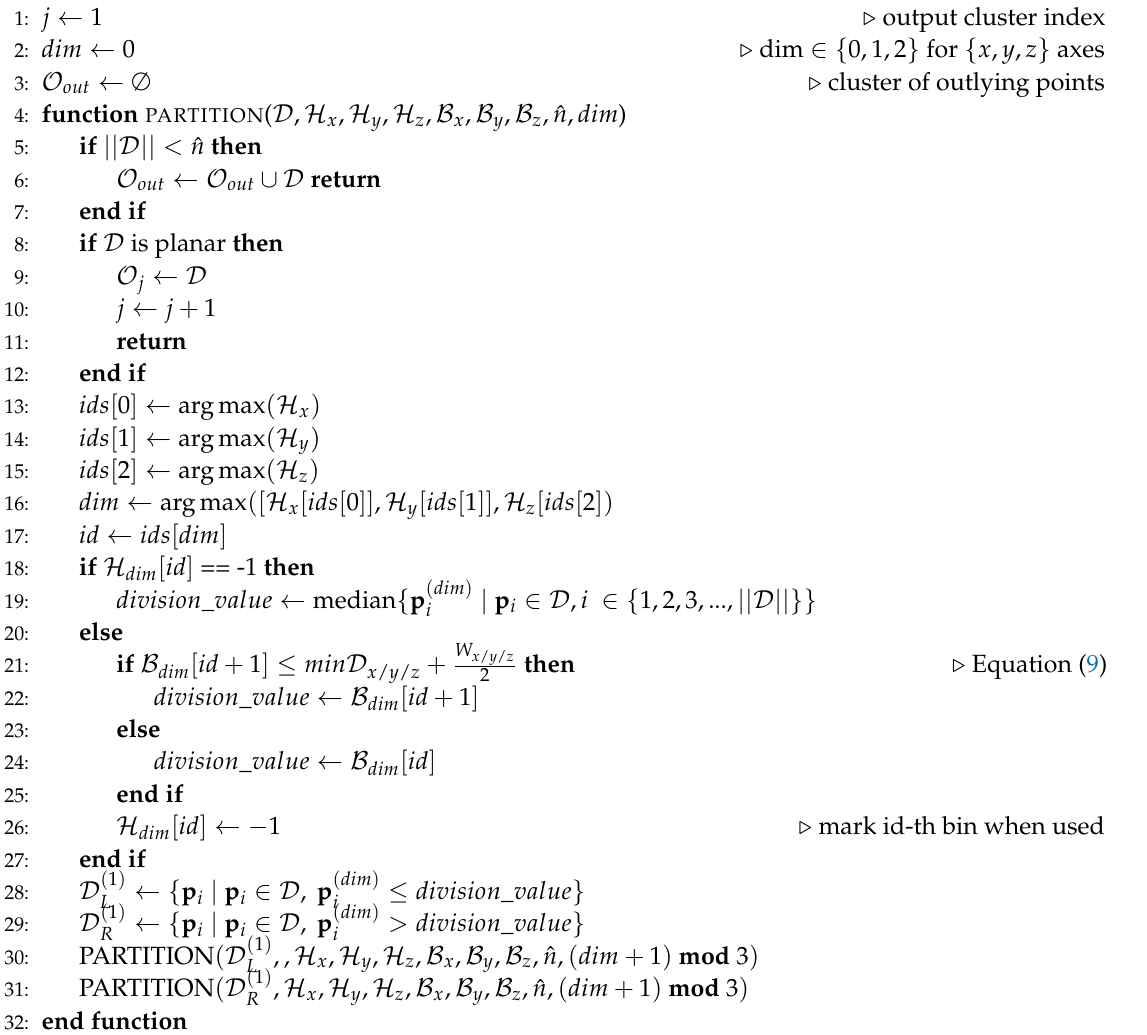
Algorithm 1 Histogram- driven partition